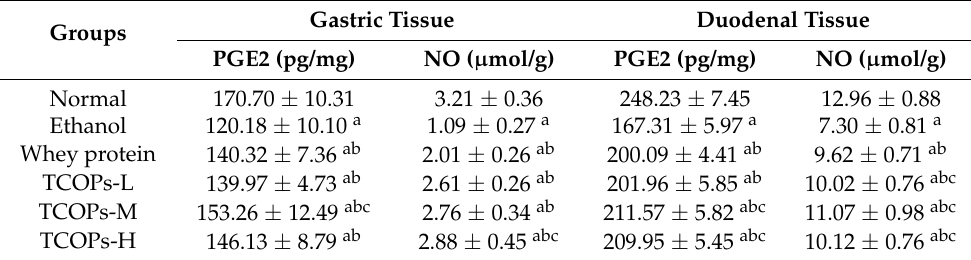
Table 9. Effect of TCOPs on PGE2 and NO in gastroduodenal tissue of